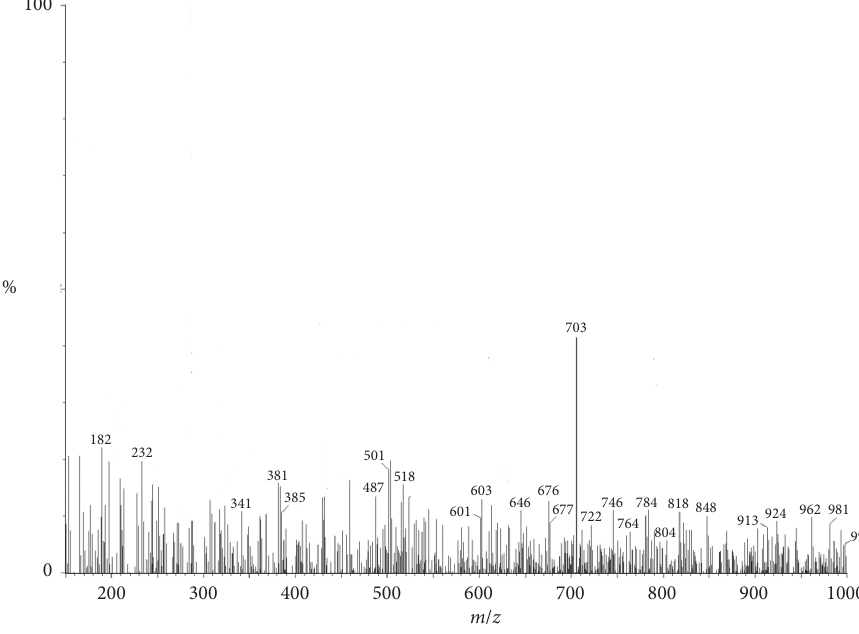
Figure 5: LC-MS spectrum of complex and products.